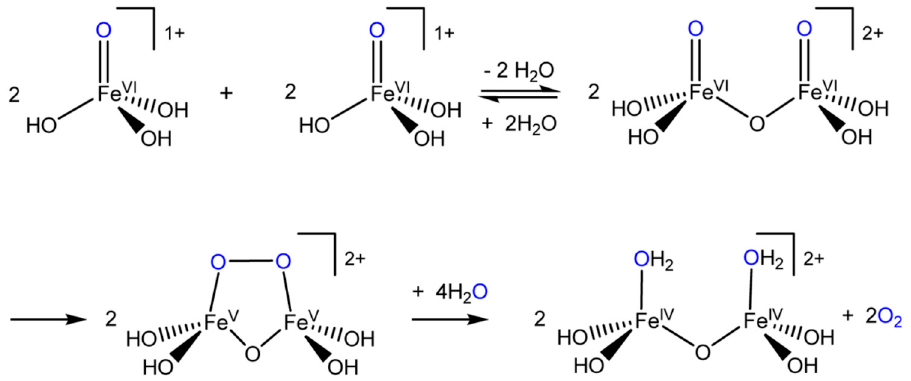
Figure 10. Oxidation of water molecules by Fe(V) dimeric complex [126].